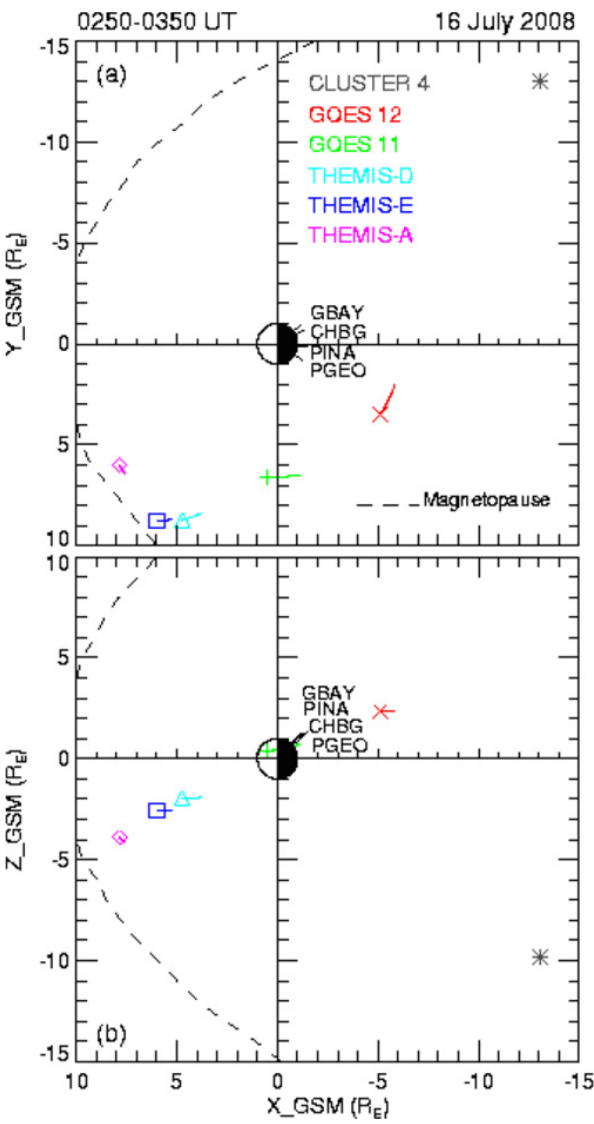
Fig. 8. The locations of THEMIS-A, THEMIS-D, THEMIS-E, GOES 11, GOES 12, and CLUSTER 4 in GSM (a) X-Y and (b) X-Z coordinates from 02:50UT to 03:50UT on 16 July 2008. The four THEMIS ground stations at mid L and the nominal magnetopause (dashed trace) are marked for